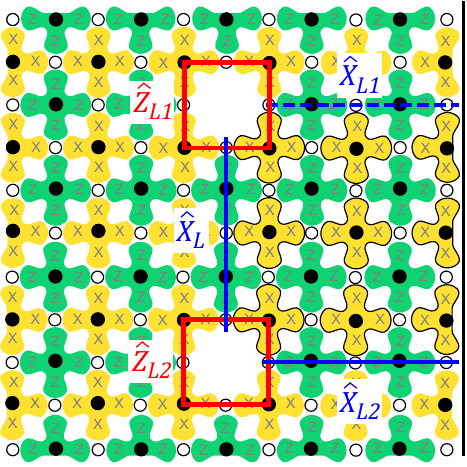
Figure 28: A double Z-cut qubit. Each Z-cut hole has the logical operators X and Z . We can replace X L 2 two separate X operators. However, X which at most give a sign change to the operator, to yield the equivalent operator X blue line) that links the two qubit holes. Figure from Ref. (Fowler, Mariantoni, Martinis and Cleland,